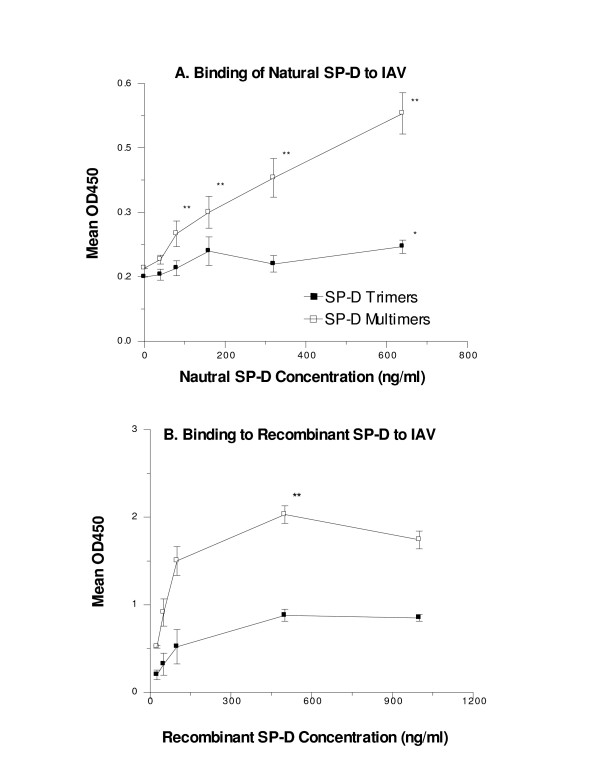
Natural SP-D multimers bind more strongly to IAV than SP-D trimers. Natural SP-D multimers and trimers were purified from amniotic fluid and tested for binding to Phil82 IAV by ELISA using the 246-04 mAb for detection of bound SP-D. Natural SP-D multimers showed significantly greater binding than trimers (** indicates p < 0.01; n = 3; Panel A). Binding of natural SP-D trimers was significantly above background binding to BSA at 640 ng/ml only (* indicates p < 0.01). In panel B we compared binding of recombinant human trimers and multimers isolated by gel filtration. Again binding of multimers was significantly greater than binding of trimers. In panel B background binding to BSA coated plates was subtracted from the results shown.